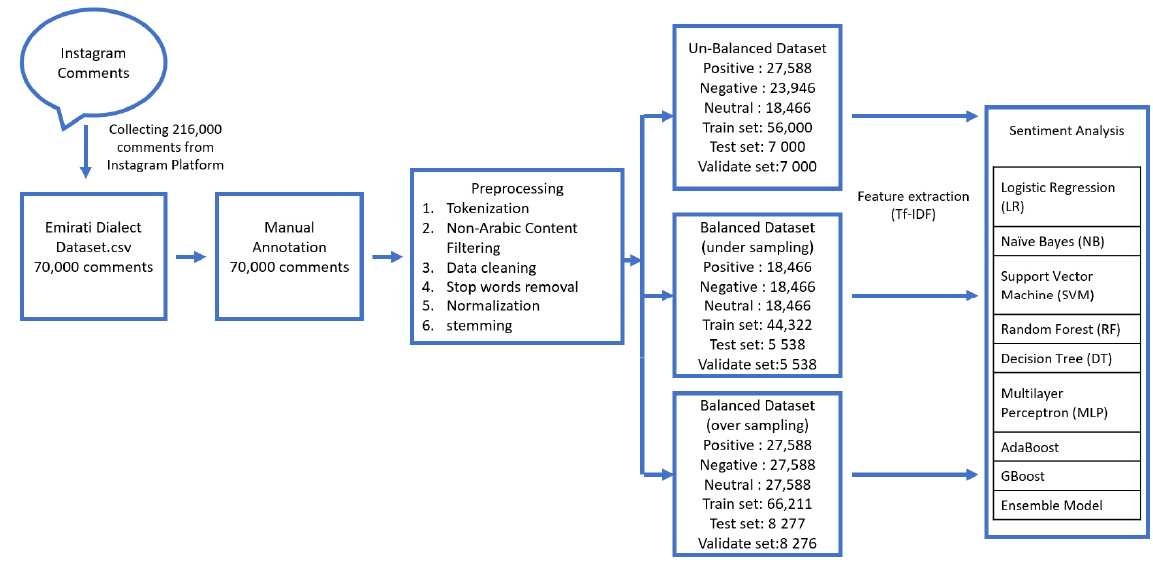
Figure 3. Sentiment analysis experiment